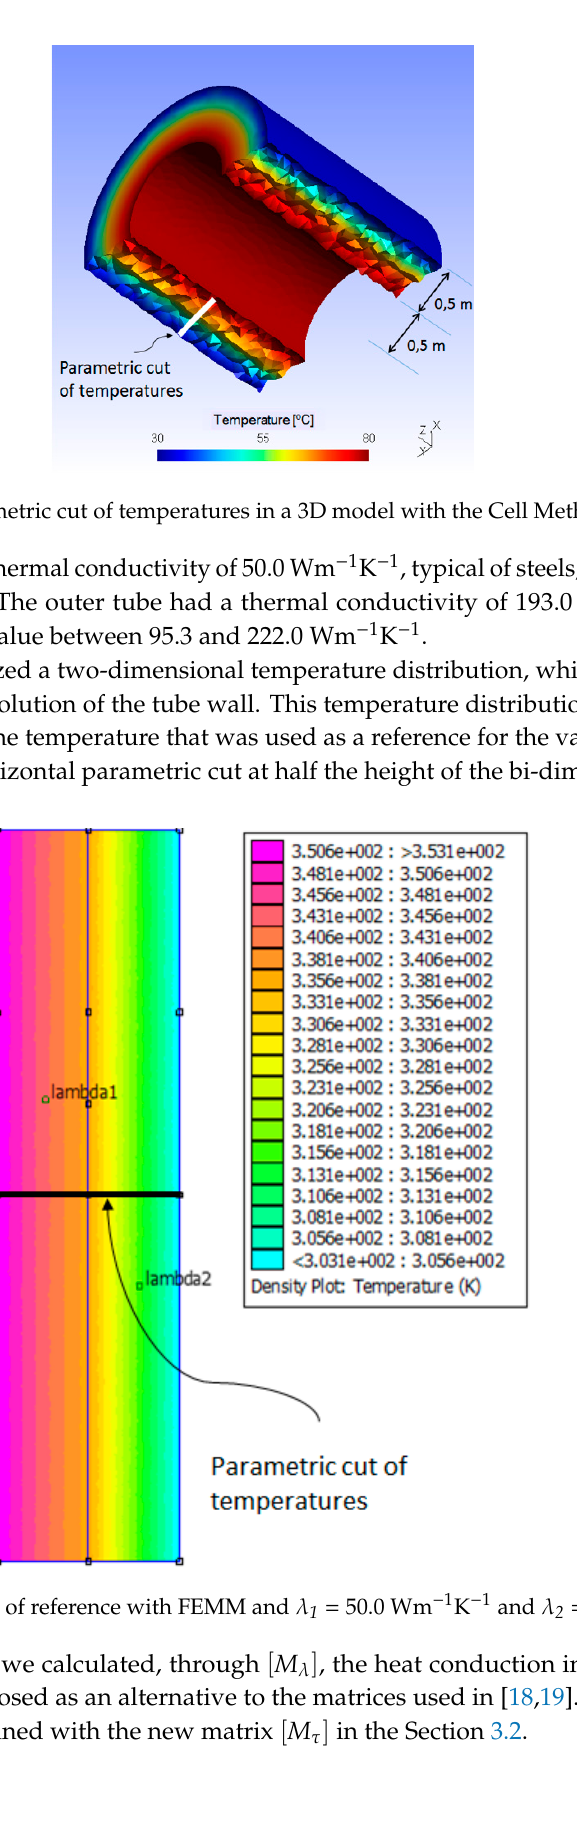
= 50.0 Wm − 1 K − 1 and λ = 193.0 Wm − 1 K − 1 1 2